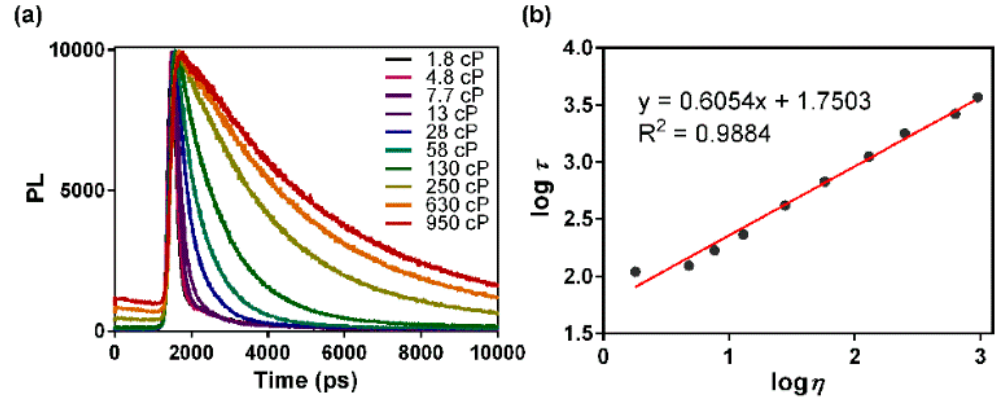
Figure 3. Viscosity-dependent fluorescence lifetime of BTV in solvent mixtures. ( a ) Changes of fluorescence lifetime of BTV (10 µM, λ ex = 430 nm, 25 °C) with the variation of solution viscosity (methanol-glycerol system); ( b ) The linear response between log τ and log η .